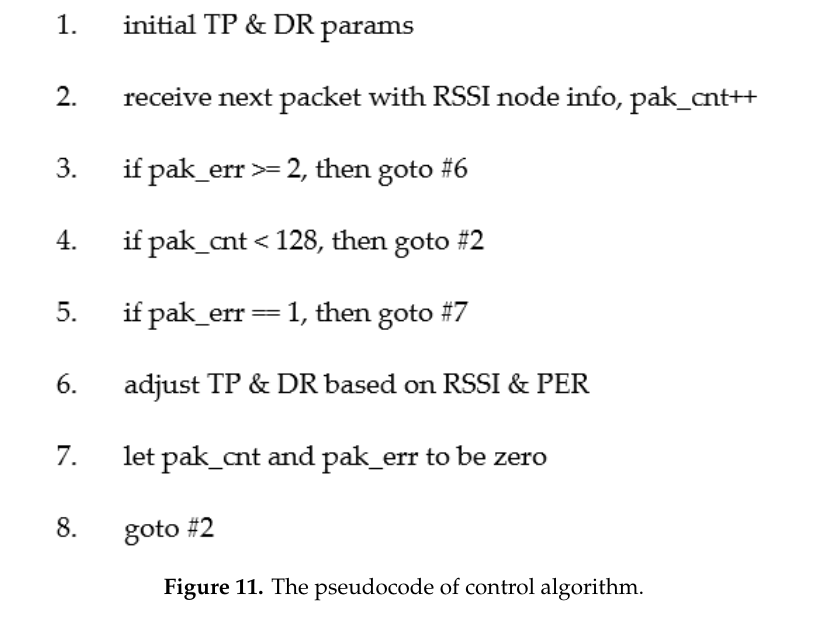
Figure 11. The pseudocode of control algorithm.